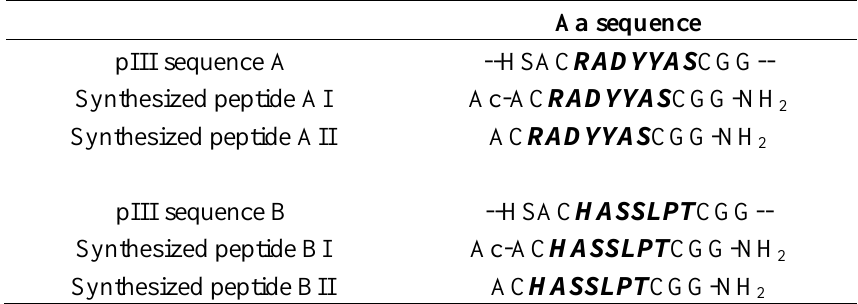
Table 1. Sequences for peptides derived from screening and